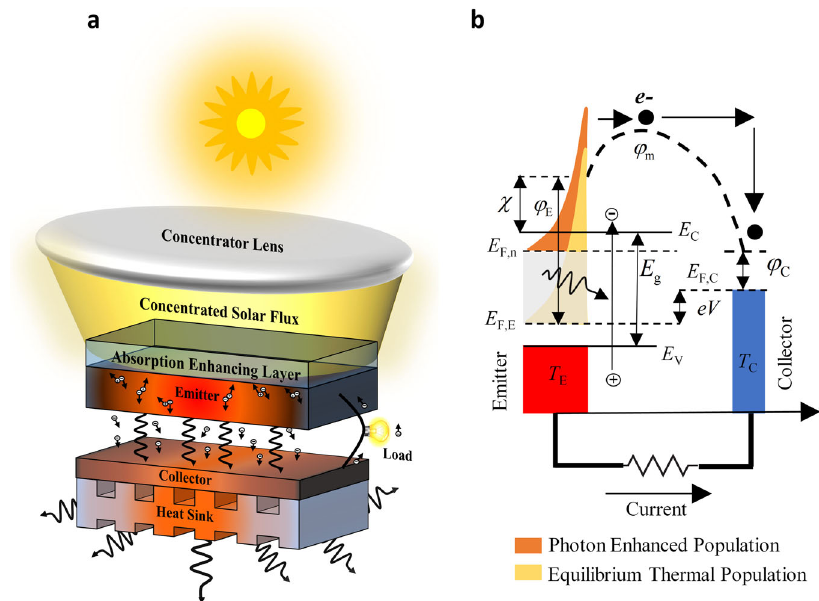
Fig. 1 Operation of a semiconductor thermionic solar cell. a The schematic of a thermionic solar converter ’ s operation. b A simple band diagram of a semiconductor thermionic solar cell. E F,E and E F,C are the equilibrium Fermi levels in the emitter and collector, respectively, and E F,n is the emitter quasi- Fermi level for electrons in the PETE mode. φ is the maximum motive in the interelectrode space and e is the electron charge. φ m functions of the emitter and the collector, respectively. T E and T C are the temperatures of the emitter and the collector, respectively. E C , E V , and E g are the conduction band minimum, the valance band maximum and the bandgap energy, respectively. V is the voltage difference between the two electrodes (and across the load).